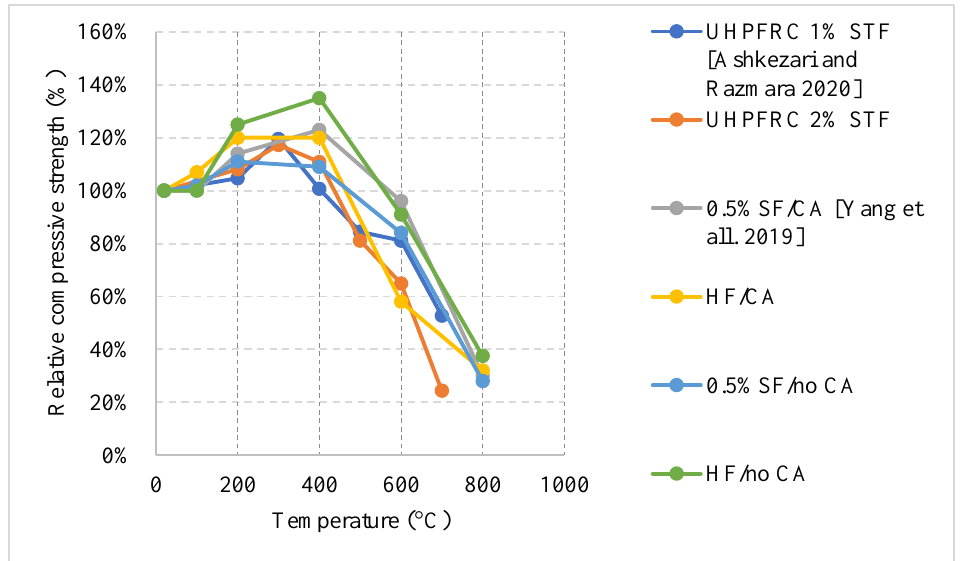
Figure 25. Relative compressive strength of naturally cooled UHPC with different constituents. STF: Steel Fiber, H: Heated, CA: Coarse aggregates, HF: Hybrid Fiber, CA: Coarse aggregate, SF: Silica fume, HF: Hybrid fiber, STF: Steel fiber, V: Volume [38,92].